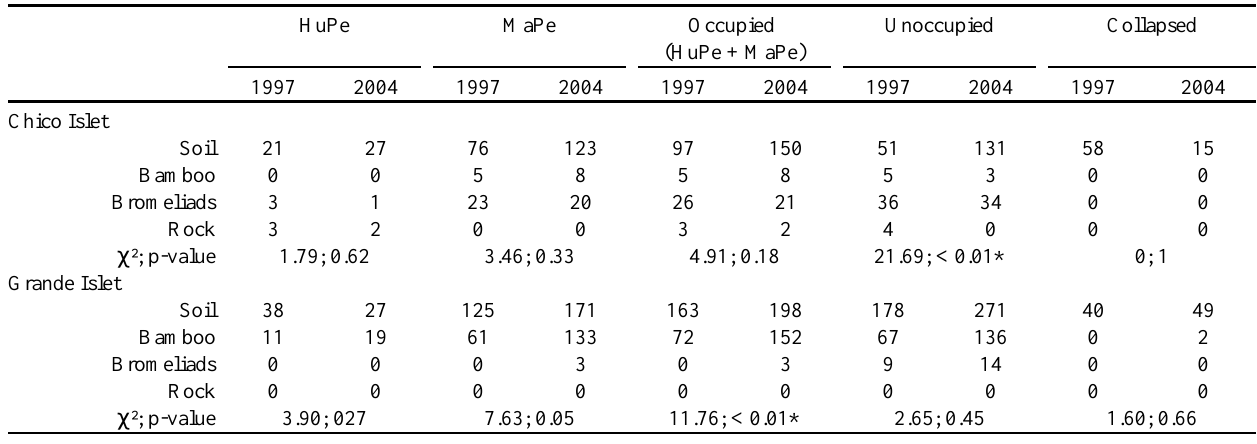
Table 3 . Observed frequencies, chi-square test, and p-values for 2 × 4 contingency tables (df = 3) reveal changes in the proportion of use in the substrate between censuses of burrows of penguins in 1997 and 2004 for occupied and unoccupied burrows in Puñihuil Islets, Chiloé, Chile. Significant values are highlighted by an asterisk (*). Humboldt penguin (HuPe; Spheniscus humboldti ), Magellanic penguin (MaPe; Spheniscus magellanicus ).